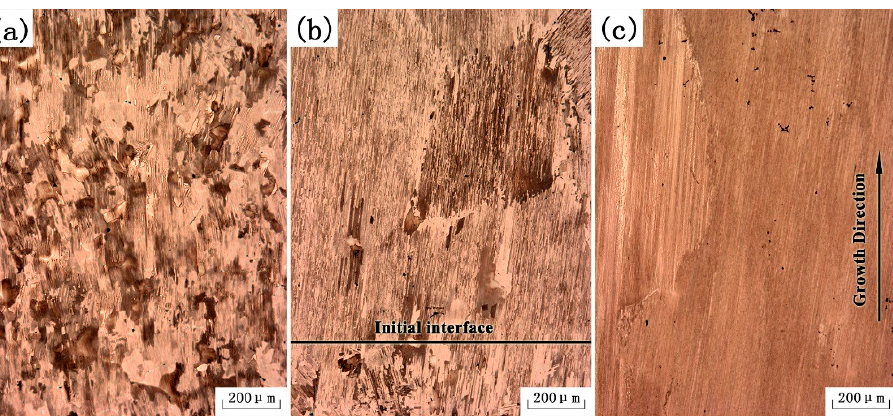
Figure 2. Microstructures of ( a ) annealing region, ( b ) initial interface and ( c ) DS region during the quasi-seeding process at 10 μ m/s.